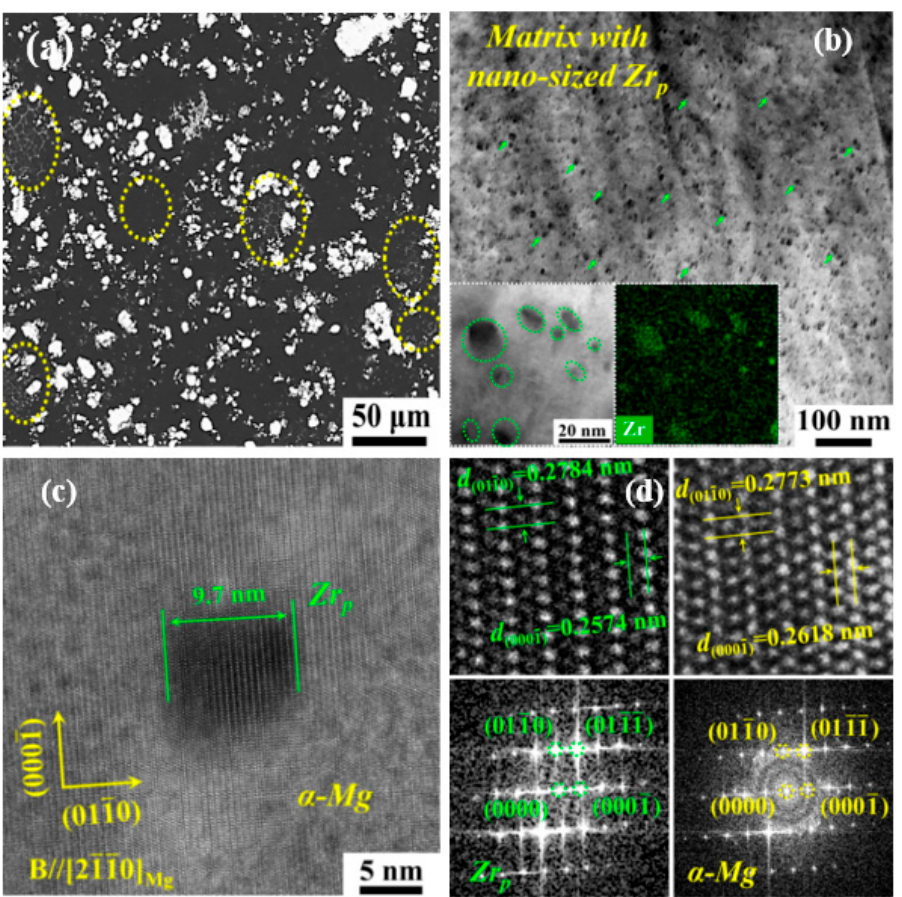
Figure 12. Characterization of UHFP-TIGR-treated Mg-30Zr master alloy: ( a ) SEM BSE image under low magnification; ( b ) TEM dark-field image; ( c , d ) HRTEM image with diffraction patterns of nanoscale Zr np [86]. Reprinted with permission from ref. [86]. Copyright 2022 Elsevier.